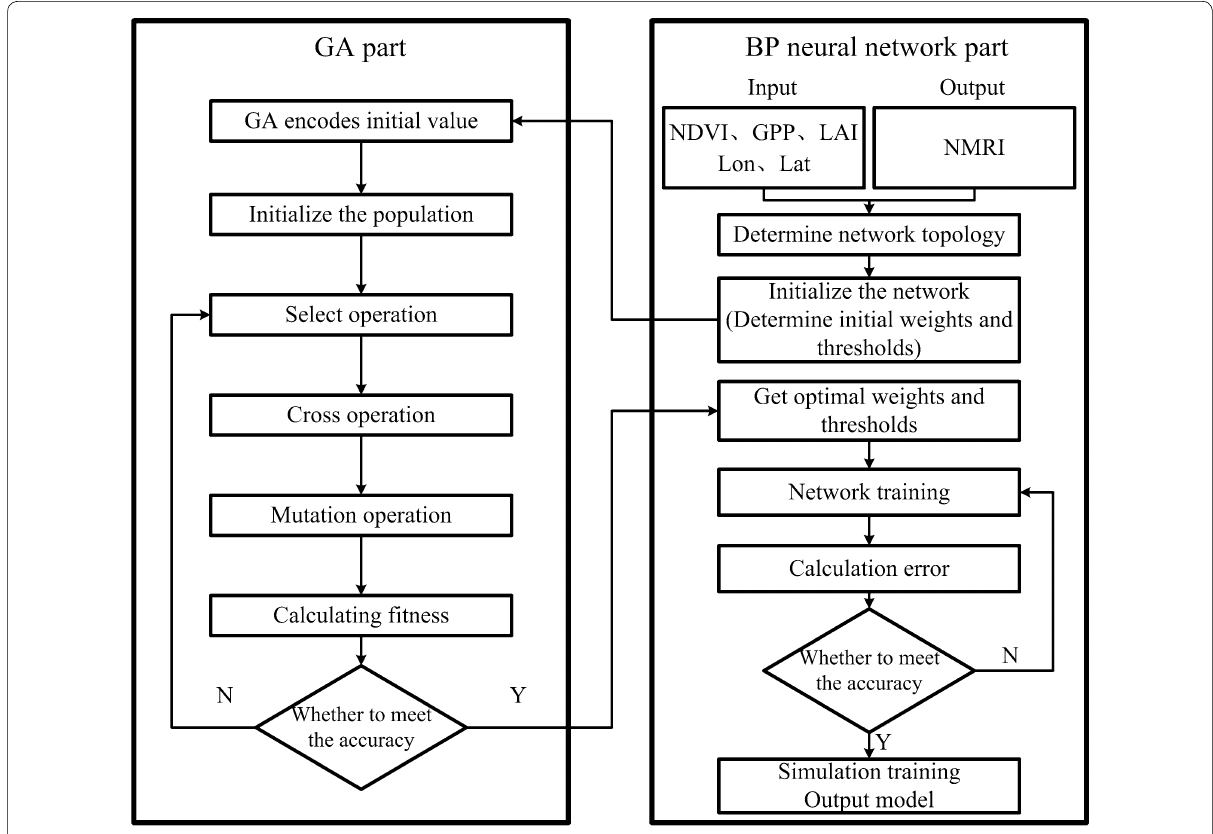
Fig. 2 GA–BP model algorithm